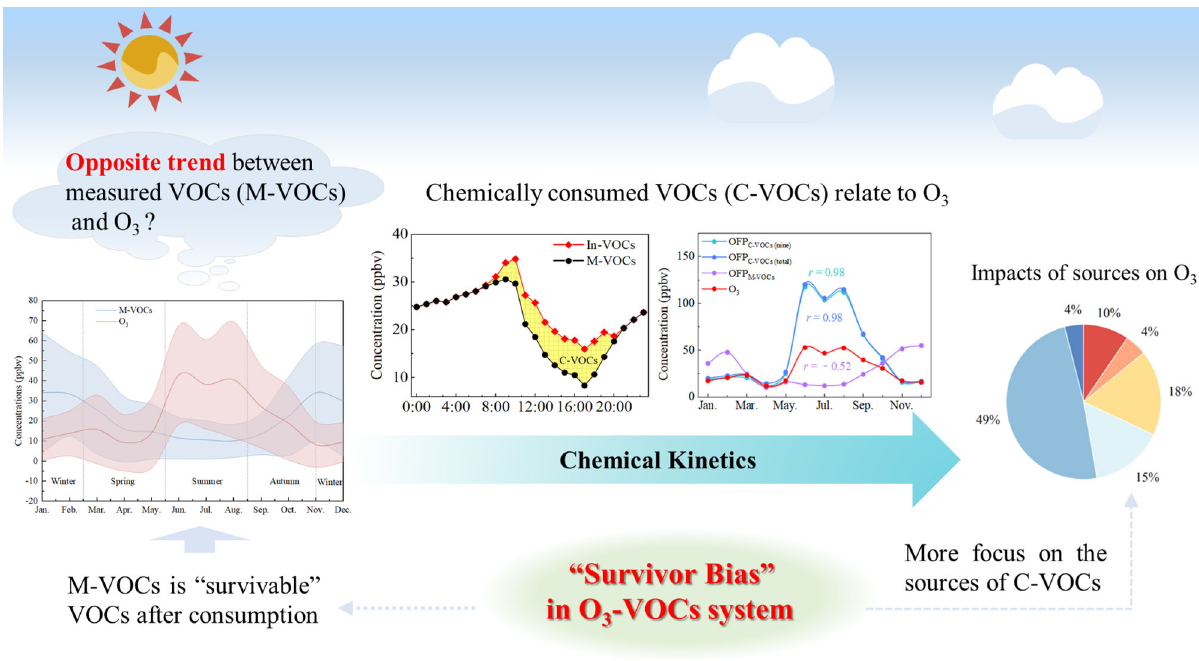
Fig. 6 Schematic diagram. This diagram explains the survivor bias for the O 3 -VOCs system. At the observation site, low-VOCs concentrations in summer correspond to high O 3 concentrations, while high VOCs concentrations in winter correspond to low O 3 concentrations. With the enhancement of photochemical reaction (in summer), VOCs with high reactivity will undergo photochemical reaction and participate in the accumulation of O 3 , resulting in less survivable M-VOCs. In contrast, a small number of VOCs were lost in winter, and the survivable M-VOCs gradually increased. Therefore, from the perspective of O 3 pollution control, we should focus more on the C-VOCs